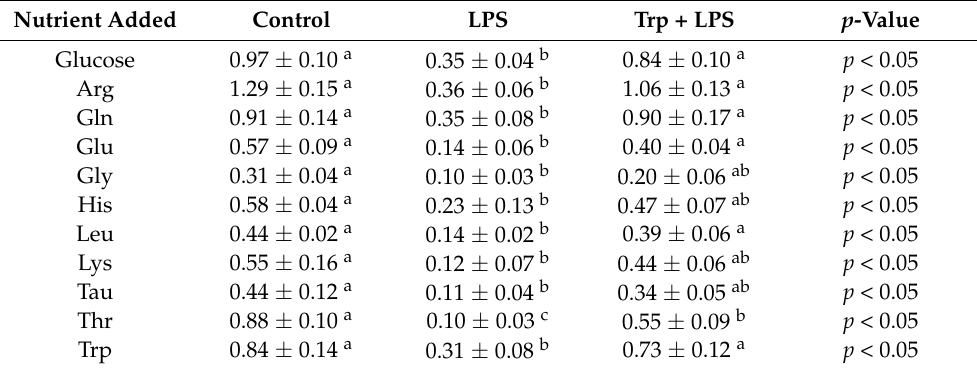
Figure 2. Effect of tryptophan supplementation on transepithelial resistance ( A ) and conductance ( B ) of the jejuna of LPS-treated rats. Values are means ± SEM, n = 8; a–c: values without a common letter differ ( p < 0.05). R t , transepithelial resistance; G t , transepithelial conductance. Table 4. Effects of tryptophan supplementation and LPS on changes of short-circuit current ( ∆ I sc ) across the jejuna of rats 1 .